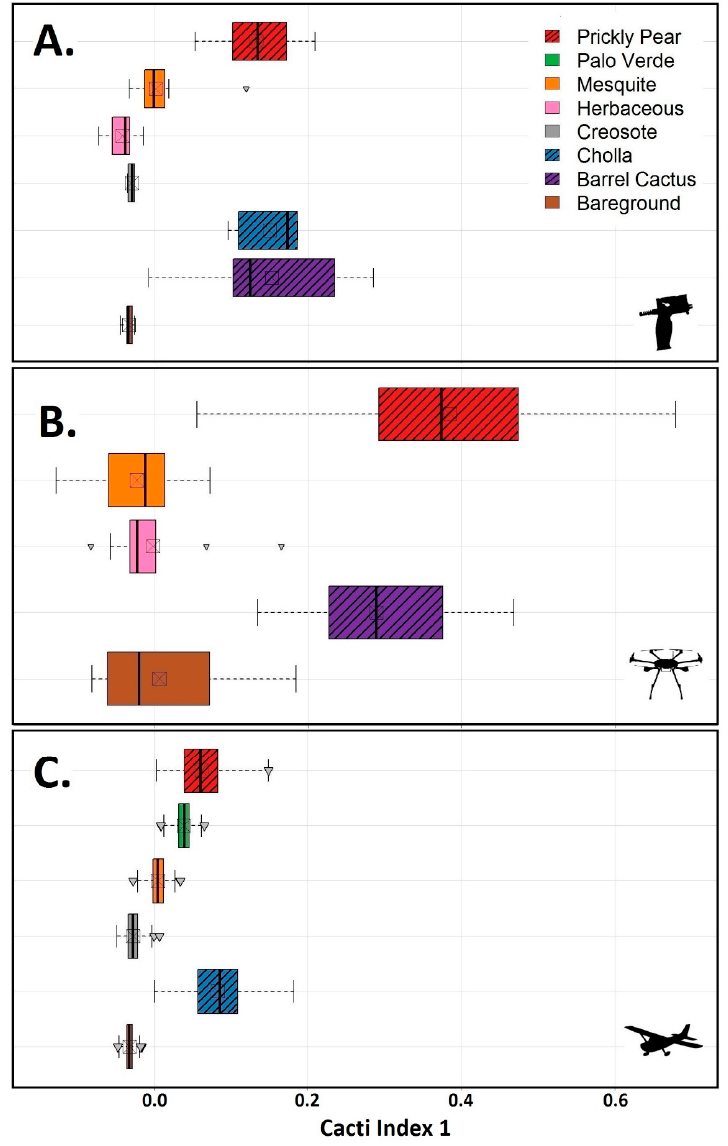
Figure 3. This graph shows the range of Cacti Index 1 (862 and 972 nm) values for cacti, non-cacti vegetation, and bare ground computed from the Field Spectrometer ( A ), Nano Hyperspectral ( B ), and NEON AVIRIS ( C ) collections. The red hatched boxes represent prickly pear, the blue hatched boxes represent cholla, and the purple hatched boxes represent barrel cactus. The square in the middle of each box is the mean for that series of samples. The whiskers represent the minimum and maximum values within the interquartile range. Any triangles outside the whiskers are outlier values.